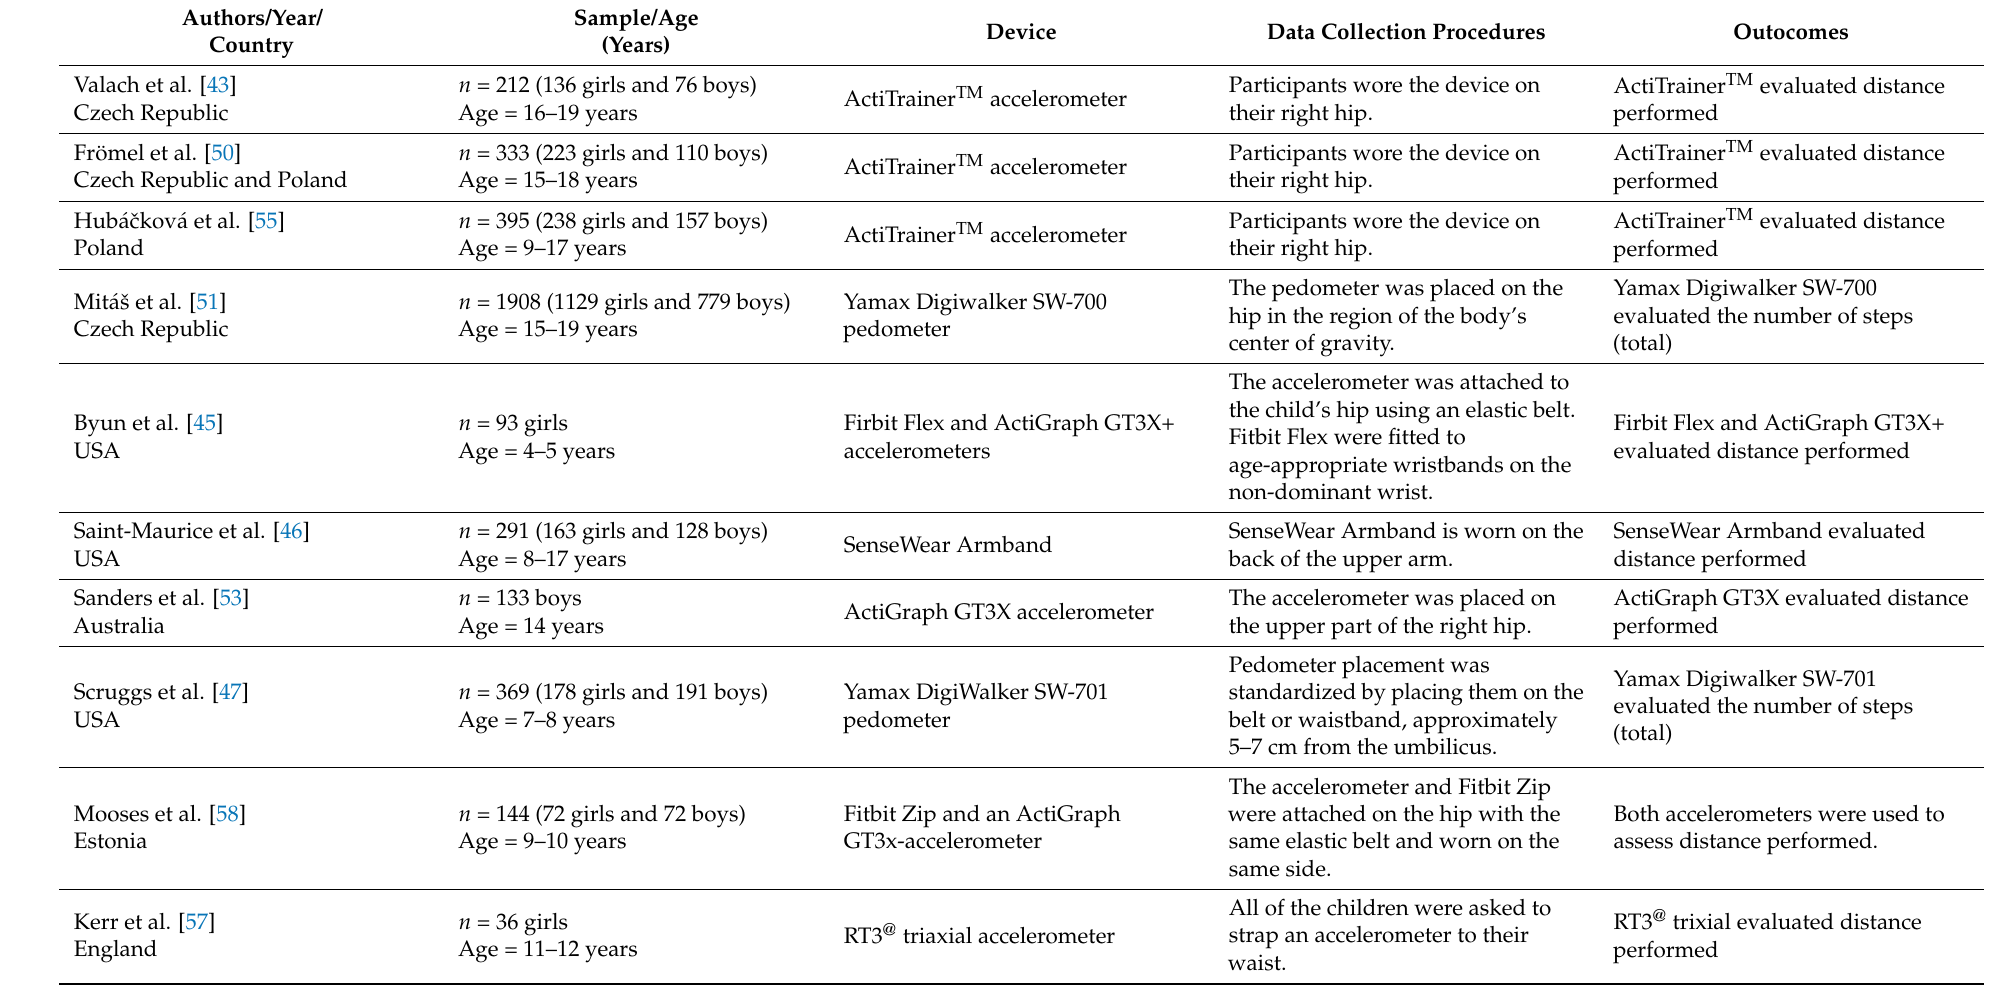
Table 1. Characteristics of the studies included in the